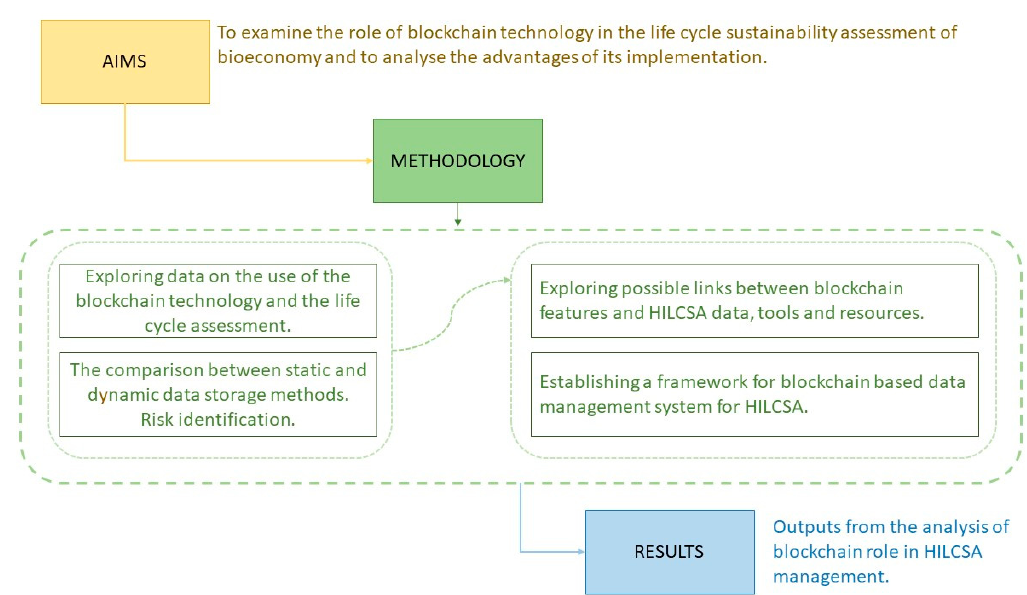
Figure 1. A flow chart summarising the aims–methodology–results path. Source: Authors.